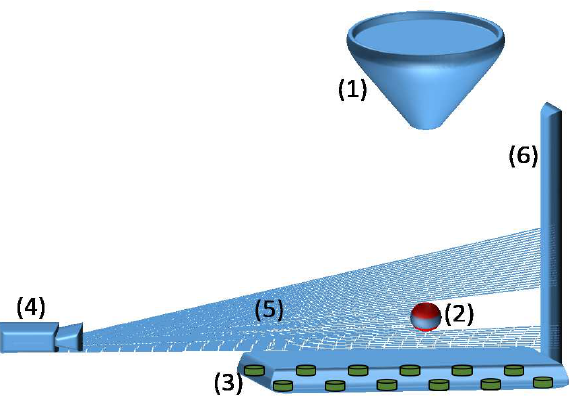
Figure 9. System illustration. (1) Cone for dropping the marble ball (2) marble (3) tested board (material) with pressure sensors below (4) laser device (5) leaser beams (6) white sticker.